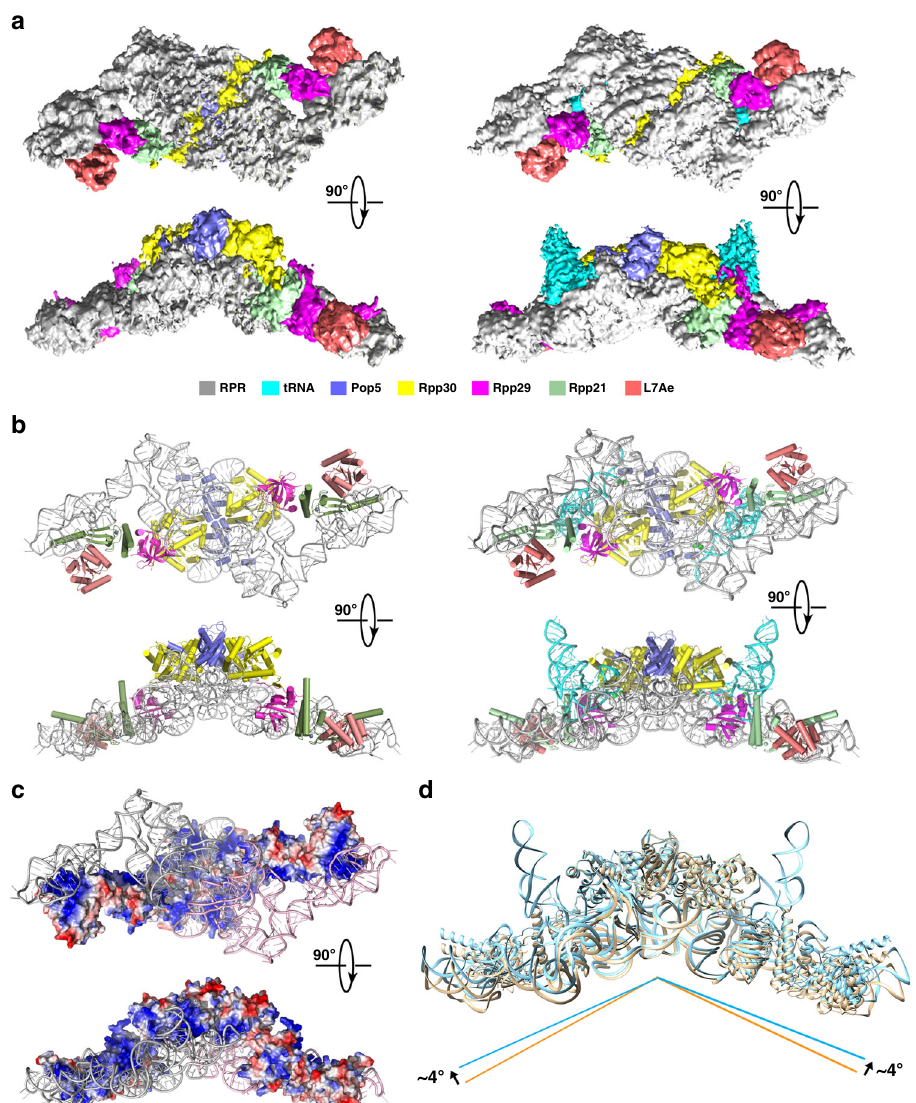
Fig. 2 Overall structures of the Mja RNase P complex with or without tRNA. a The cryo-EM density maps of Mja RNase P (left) and the Mja RNase P-tRNA Tyr complex (right) are shown in two orthogonal views. Protein and RNA components are color-coded and the scheme is shown below the fi gure. b Two orthogonal views of the atomic model of Mja RNase P (left) and the Mja RNase P-tRNA complex (right) are shown in cartoon representation. Protein and RNA components are color-coded as in ( a ). c Two orthogonal views of the surface electrostatic potential of the protein assembly in Mja RNase P reveals a continuous highly basic surface that binds two RPRs (negative: red; positive: blue). The two RPRs are colored in pink and gray, respectively. d Superposition of the structures of Mja RNase P with or without tRNA shows that tRNA binding only induces a ~8° change in the angle between the two Mja RNase P monomers. Mja RNase P and the Mja RNase P-tRNA complex are colored in wheat and palecyan,